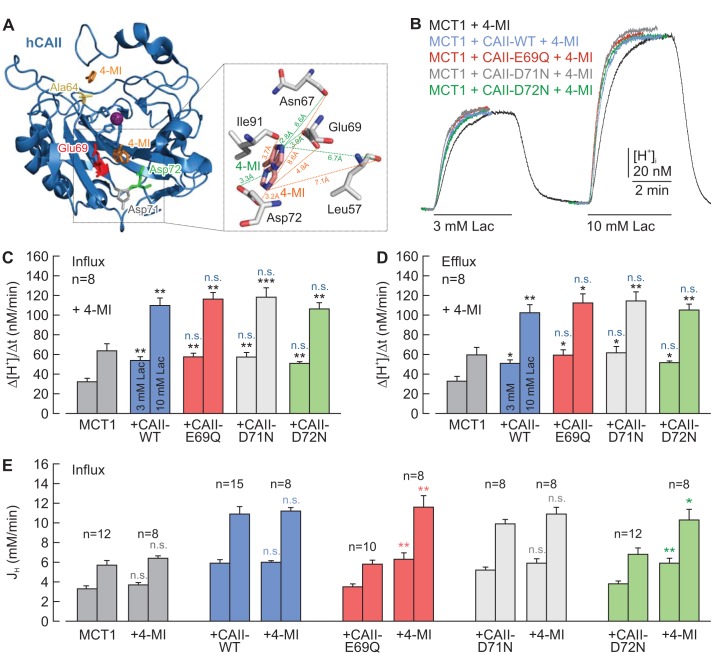
Chemical rescue of the interaction between MCT1 and CAII-E69Q/D72N by 4-methylimidazole.(A) Structural model of human CAII, complexed with 4-methylimidazole (4-MI) (PDB-ID: 1MOO; Duda et al., 2003). 4-MI binds near His64 or in a moiety between Glu69 and Asp 72. Inset: Close-up of the binding moiety. 4-MI can bind in two alternative confirmations (orange and green) between Leu57, Asn67, Glu69, Asp72, and Ile91. (B) Original recordings of the change in intracellular H+ concentration in oocytes expressing MCT1 (black trace), MCT1 +CAII-WT (blue trace), MCT1 +CAII-E69Q (red trace), MCT1 +CAII-D71N (gray trace), and MCT1 +CAII-D72N (green trace), during the application of 3 and 10 mM lactate. All oocytes were injected with 4-MI (30 mM) on the day that the measurements were carried out. (C, D) Rate of change in intracellular H+ concentration (Δ[H+]/Δt) as induced by the application (C) and the removal (D) of 3 and 10 mM lactate, respectively, in oocytes expressing MCT1 (dark gray), MCT1 +CAII-WT (blue), MCT1 +CAII-E69Q (red), MCT1 +CAII-D71N (light gray), and MCT1 +CAII-D72N (green) (mean +SEM). The black significance indicators refer to MCT1, the blue significance indicators refer to MCT1 +CAII. All oocytes were injected with 4-MI (30 mM) on the day that the measurements were carried out. (E) Lactate-induced proton flux (JH), as calculated from the rate of change in pHi and the cells intrinsic buffer capacity (βi; Figure 5—figure supplement 1), in oocytes expressing MCT1 (dark gray), MCT1 +CAII-WT (blue), MCT1 +CAII-E69Q (red), MCT1 +CAII-D71N (light gray), and MCT1 +CAII-D72N (green), either injected with 4-MI or not (mean +SEM). The significance of difference indicators above the bars from 4-MI-injected oocytes refer to comparisons with cells expressing the same proteins without 4-MI. *p≤0.05, **p≤0.01, ***p≤0.001, n.s. no significance; Student’s t-test.10.7554/eLife.35176.018Figure 5—source data 1.Original dataset for Figure 5.